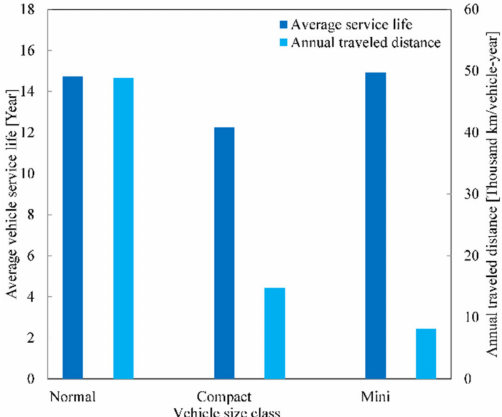
Figure 3. Vehicle service lives and annual traveled